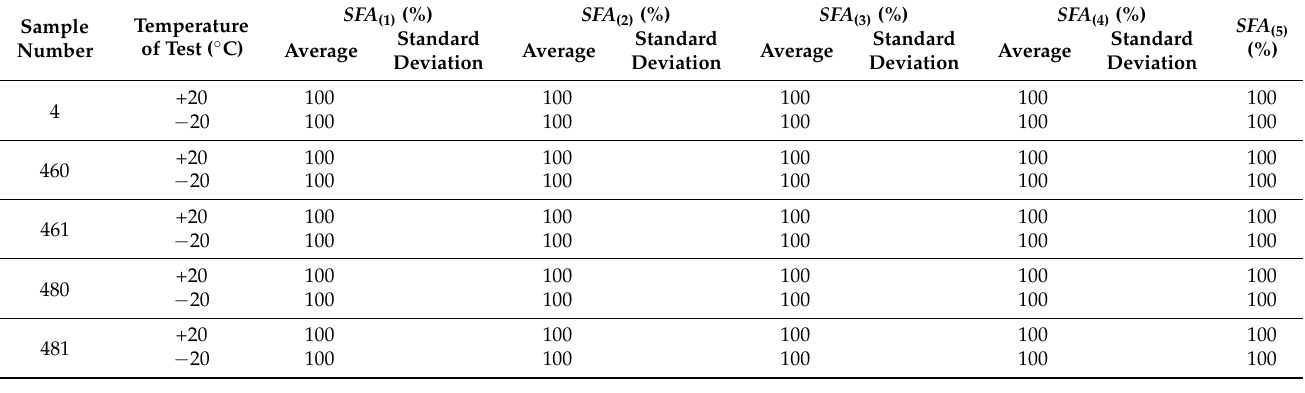
Table 9. Values of the SFA ( n ) (%) parameters determined for X2CrNiMoN22-5-3 steel, determined on impact toughness test fractures obtained during this research.